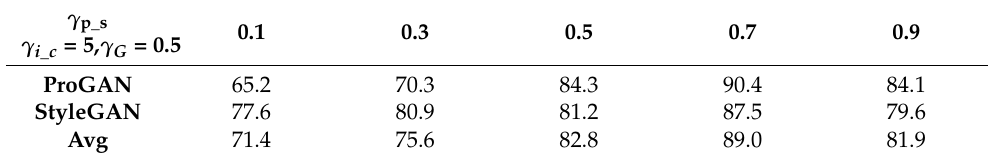
Table 2. Hyper-parameter analysis in pupil shape estimation (Test criteria adopt accuracy (%)). γ p_s